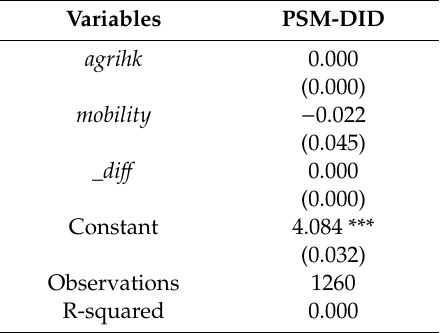
Table 8. Result of PSM-DID (Propensity score matching combined Di ff erence-in-Di ff erence) model.